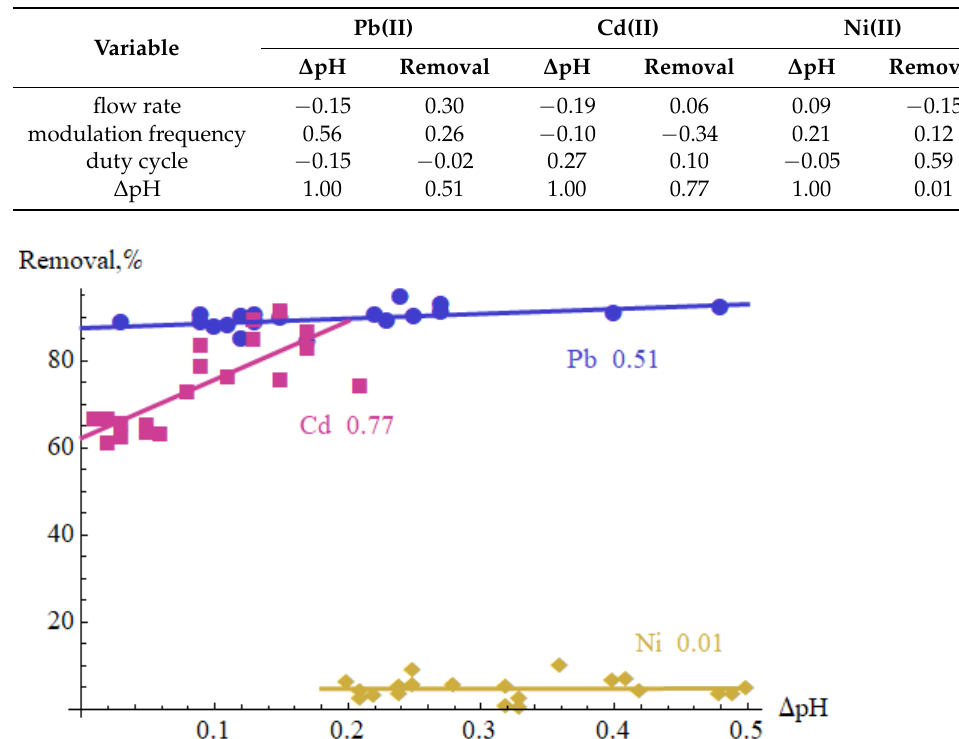
Table 6. Pearson correlation coefficients between generator settings and observables.